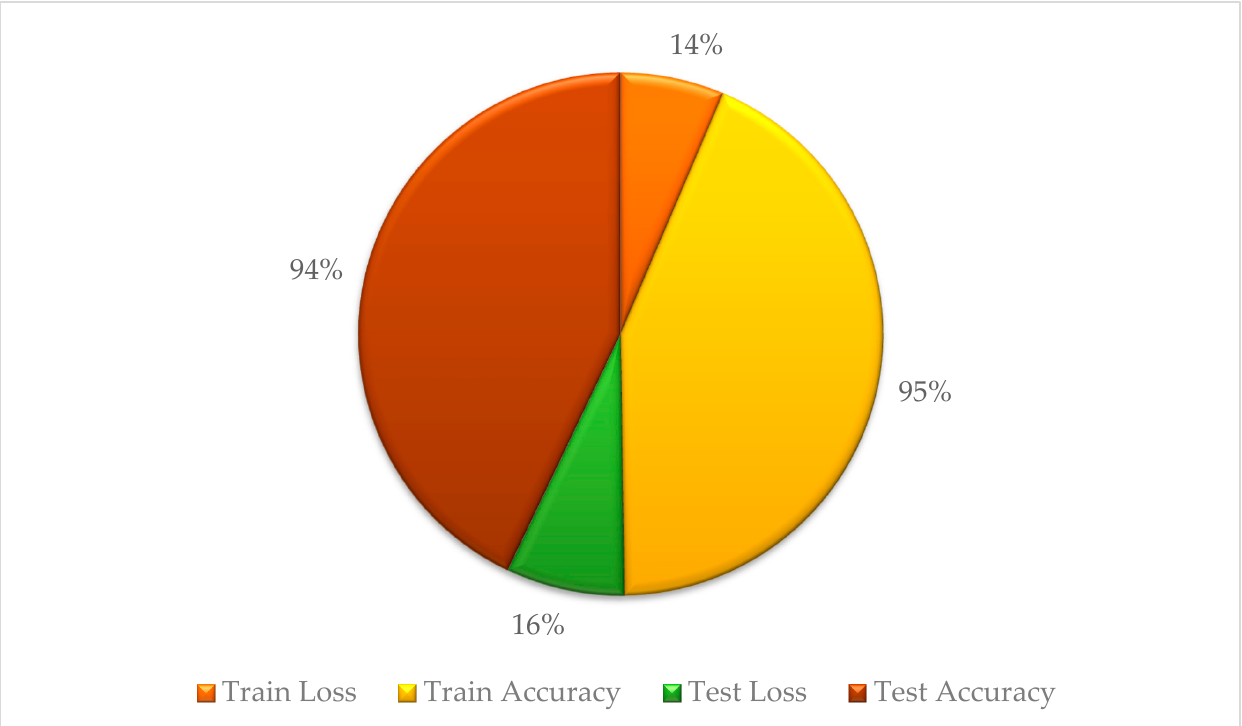
Figure 12. Trained model characteristics.